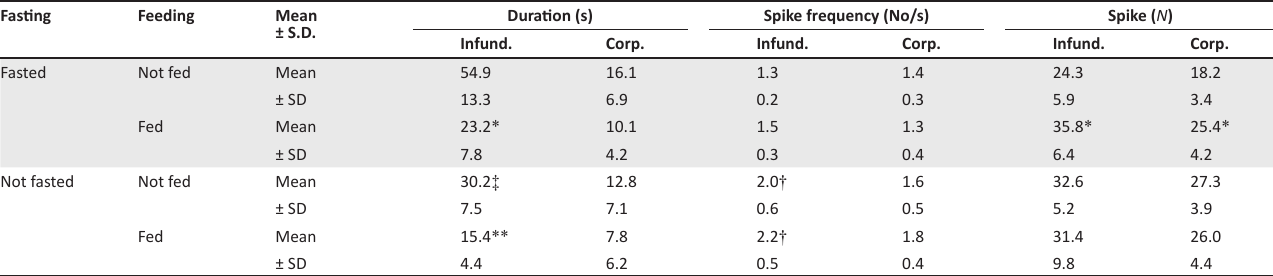
TABLE 4: Characteristics of the longer fragment of the long spike burst pattern recorded in the gallbladder infundibulum and corpus in various feeding conditions. Fasting Feeding Mean Duration (s) Spike frequency (No/s) Spike ( N ) ± S.D. Infund. Corp. Infund. Corp. Infund. Fasted Not fed Mean 54.9 Fed Mean 23.2 * ± SD Not fasted Not fed Mean 30.2 ‡ Fed